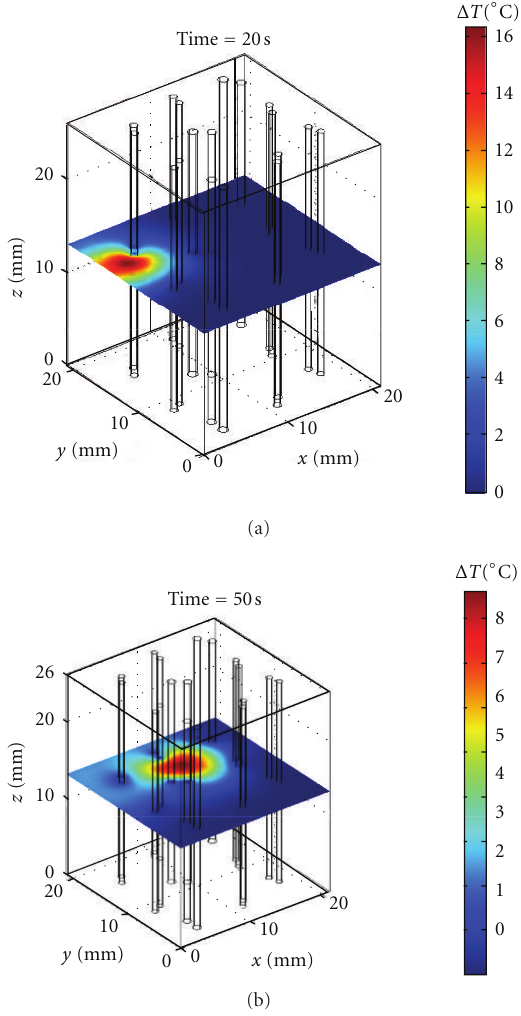
Figure 8: Temperature distribution reached in the midplane for the multiple artery-vein vessel pairs at the end of the first insonation period (a) and at the end of the second cooling period (b) for the random insonation treatment with peak power density of 17.5 W/cm 3 . The other parameters are illustrated in the